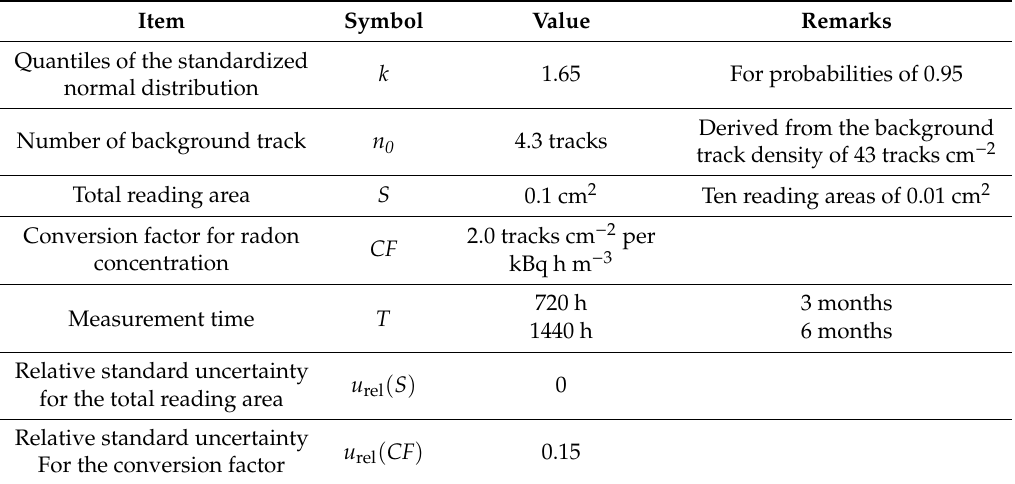
Table 2. Parameters used for the calculation of the minimum detectable radon concentration.